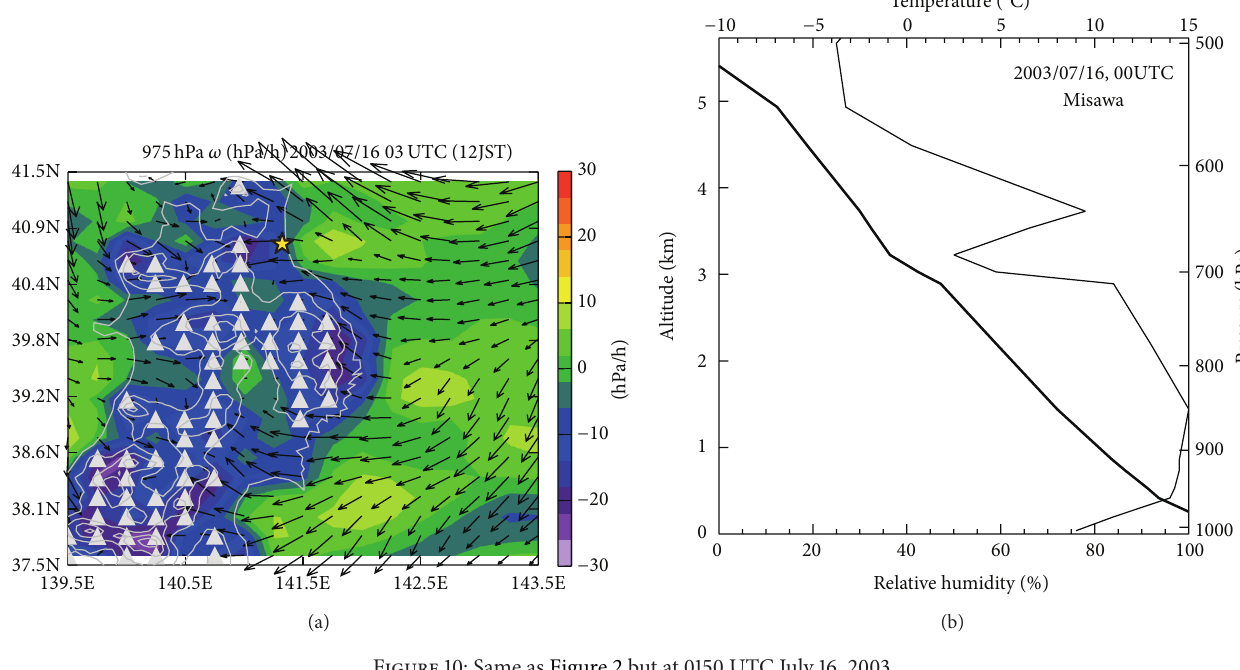
Figure 10: Same as Figure 2 but at 0150 UTC July 16, 2003.